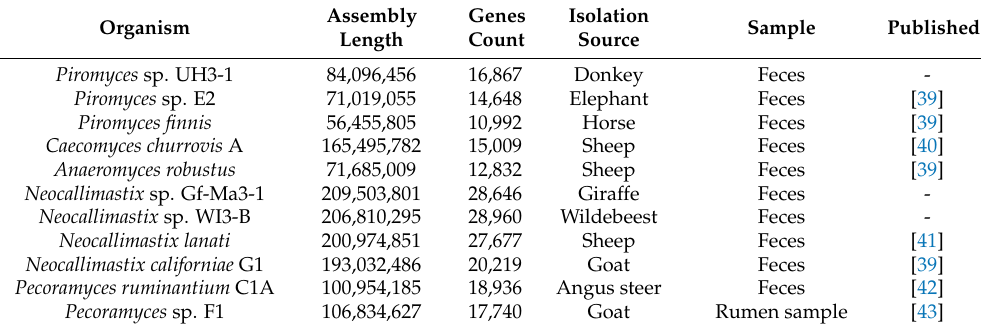
Table 1. The anaerobic fungal isolates (11) that have been genome-annotated in recent